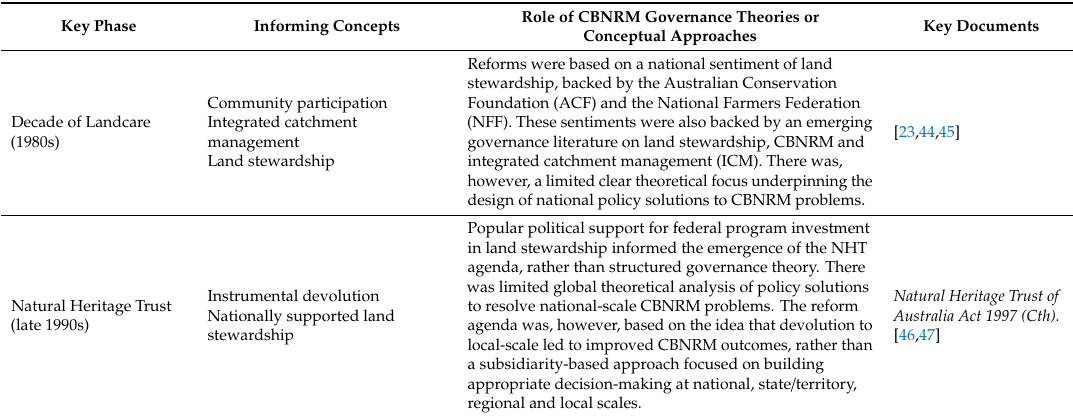
Table 1. The role of governance theories in di ff erent national community-based natural resource management (CBNRM)